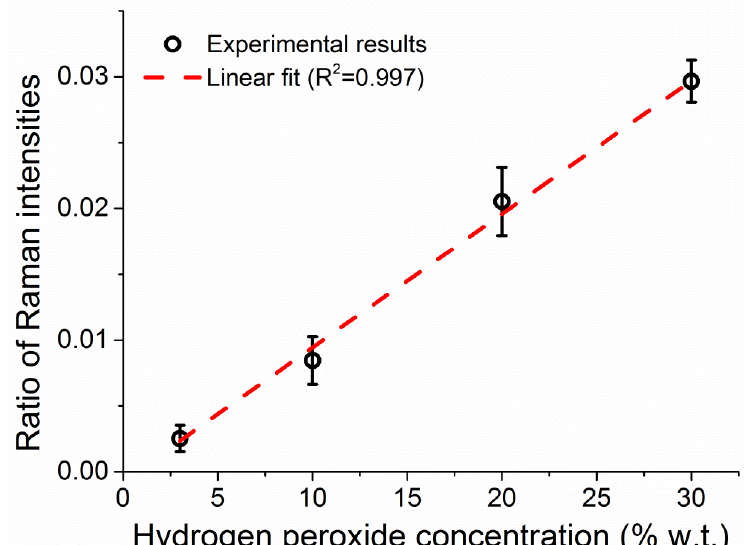
Figure 8. The ratio of the integrated Raman intensities of hydrogen peroxide and water in an aqueous solution inside a suspended core fiber as a function of the peroxide concentration. The dashed line is a linear fit ( R 2 =